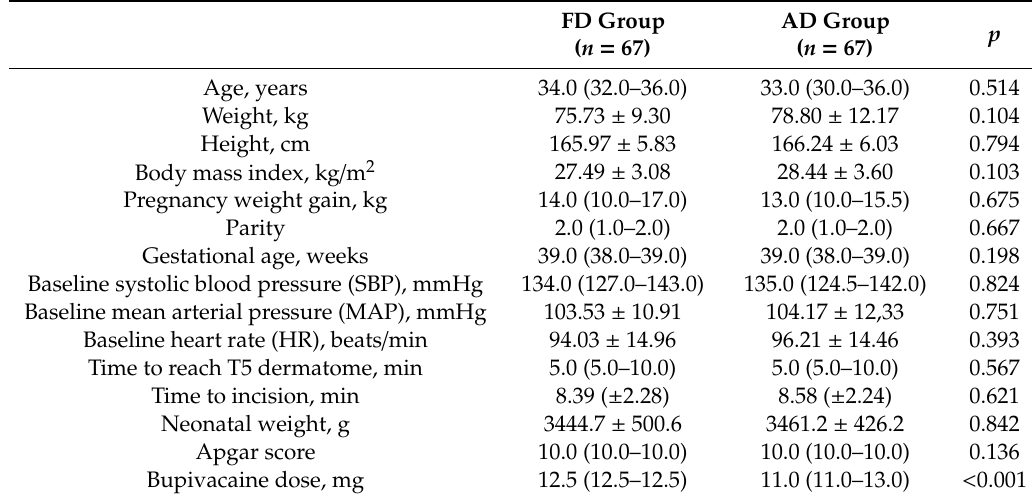
Table 2. Demographic, obstetric and procedure-related data.